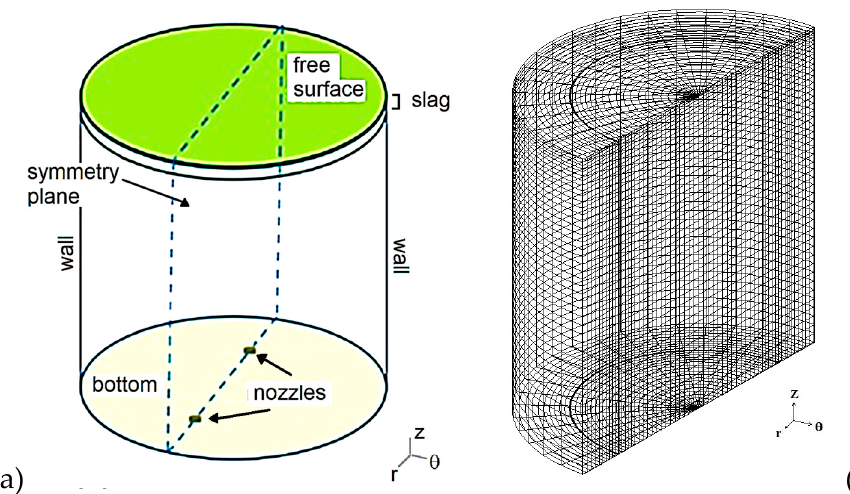
Figure 1. ( a ) Schematic view of the gas stirred ladle with nozzle (both single and dual plug gas injections), ( b ) Cylindrical grid coordinates of the ladle (axisymmetric section) used in the simulations.